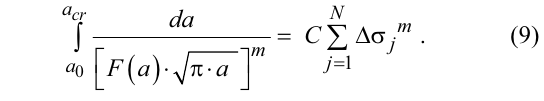
Fig. 1. Structural detail with initial crack